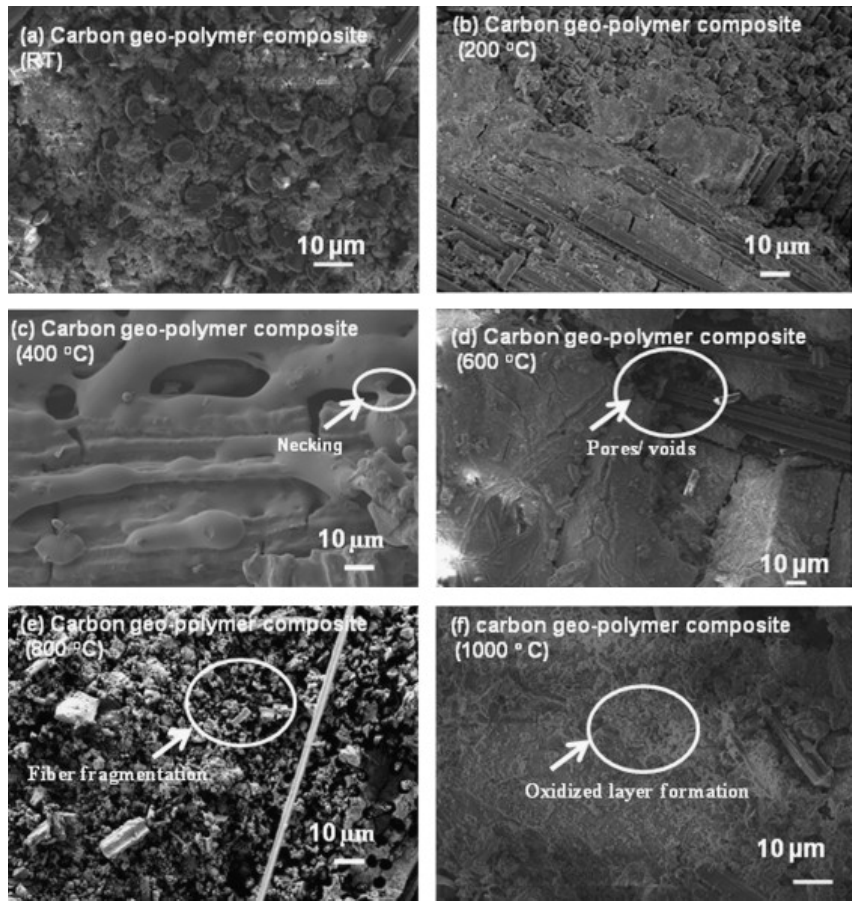
Figure 8. Surface image of ( a ) geopolymer composites with incorporated carbon fabrics (RT), ( b ) geopolymer composite (200 °C), ( c ) geopolymer composite (400 °C), ( d ) geopolymer composite (600 ( b ) geopolymer composite (200 ◦ C), ( c ) geopolymer composite (400 ◦ C), ( d ) geopolymer composite °C), ( e ) geopolymer composite (800 °C), and ( f ) geopolymer composite (1000 °C). (600 ◦ C), ( e ) geopolymer composite (800 ◦ C), and ( f ) geopolymer composite (1000 ◦